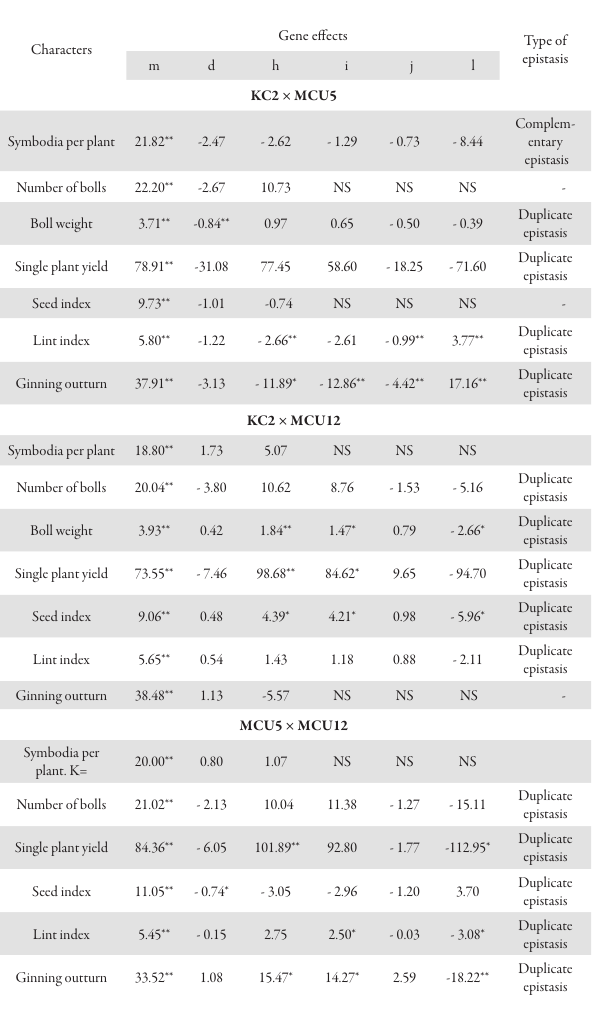
Tab. 1. Gene effects and type of epistasis (gene interaction) for lint yield and their components characters in upland